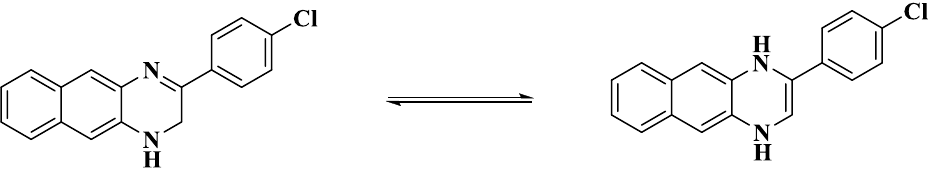
Figure 2. Two isomers of compound 2 .